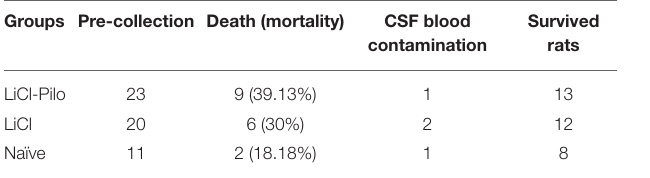
TABLE 1 | Numbers of rats enrolled in CSF collection ( n ).